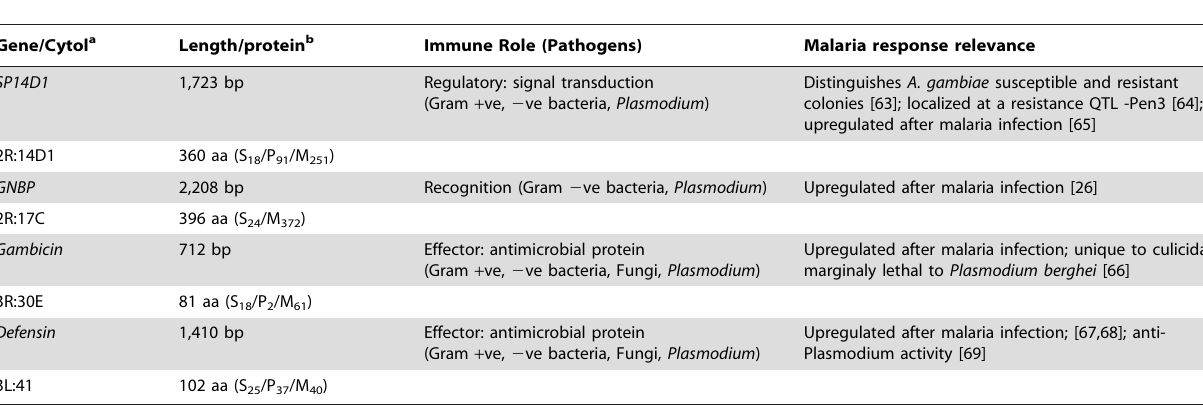
Table 1. Location, basic structure, and function of selected genes.